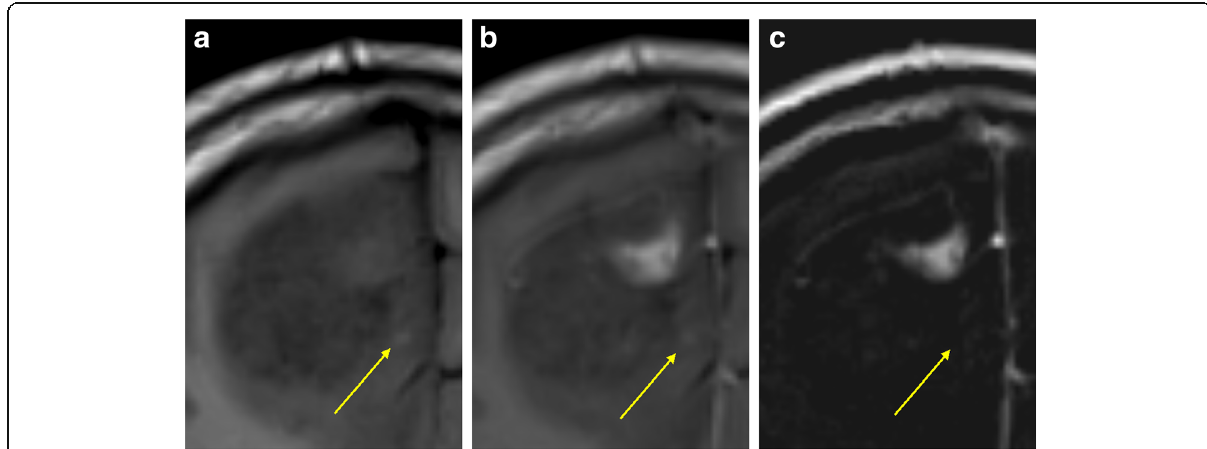
Fig. 3 The quantitative enhancement (QE) analysis system considers both unenhanced ( a ) and contrast-enhanced ( b ) T1-weighted images when calculating the QE map ( c ) and thus knows that regions that are bright on the contrast-enhanced image (arrow) are not enhancing if they are equivalently bright in the unenhanced image